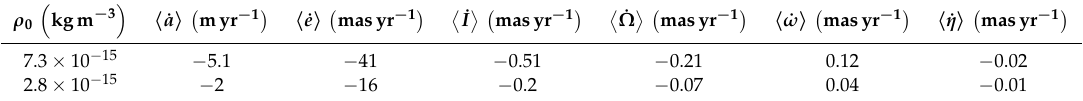
Table A6. Orbital configuration of the proposed satellite HERO: low perigee case. The orbital motion is relatively slow since the orbital period P b is as long as more than 21h. The period P ω of the perigee is mainly determined by its secular precession due to J 3 , J 4 because of the critical inclination which makes the secular precession due to J 2 nominally vanishing. The period P Ω of the node is rather long, amounting to more than 13yr.